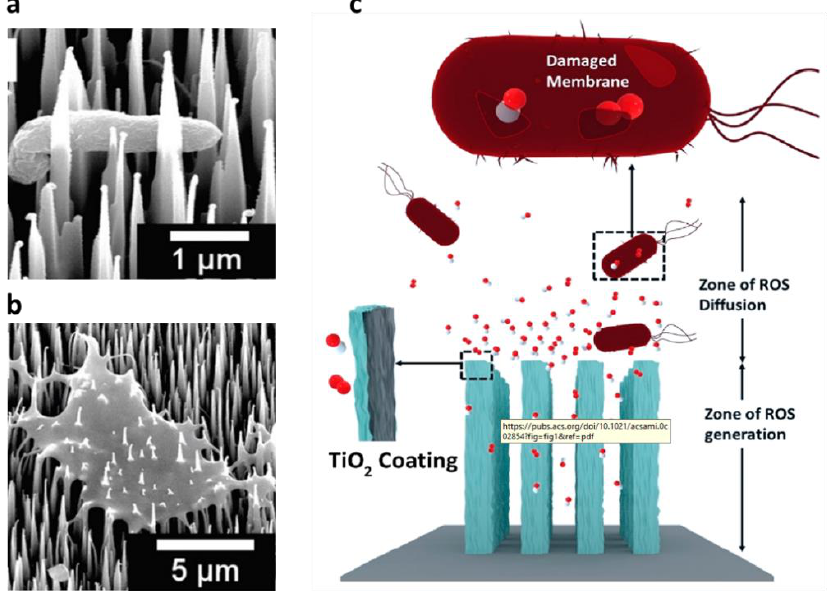
Figure 14. Applications of black silicon as antibacterial material. ( a ) SEM of bacteria trapped in black silicon. Adapted from reference [112], with permission from Royal Society of Chemistry © 2020. ( b ) SEM of bacterium punctured by nanostructures on black silicon surface. Adapted from reference [113]. ( c ) Reactive oxygen species (ROS) is produced by the photocatalysis of TiO 2 to decompose bacteria. Adapted from reference [114].